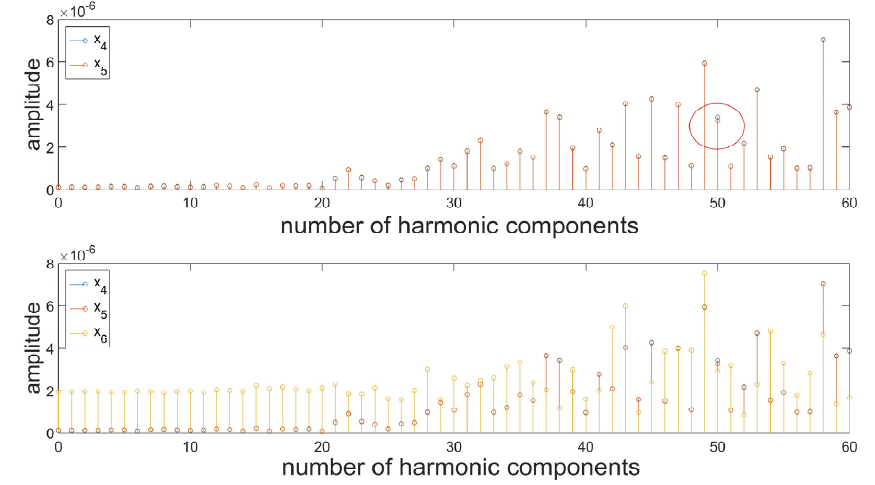
Figure 9. A spectrum of surface profiles on the first level of decomposition—the db2 wavelet.